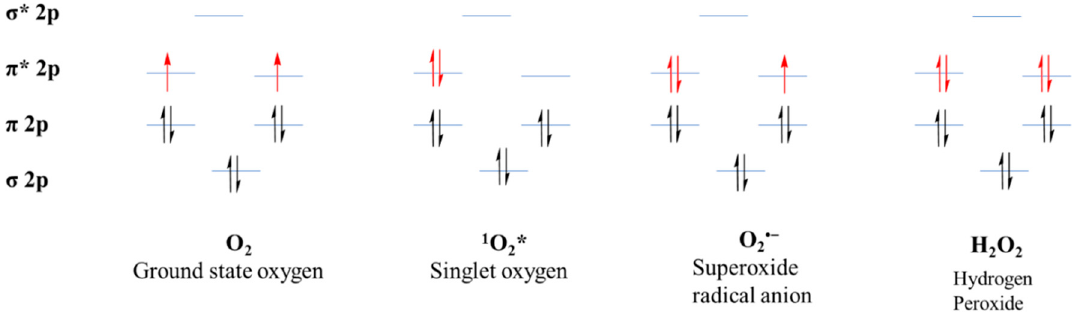
Figure 2. Electronic configuration of reactive oxygen species (ROS).